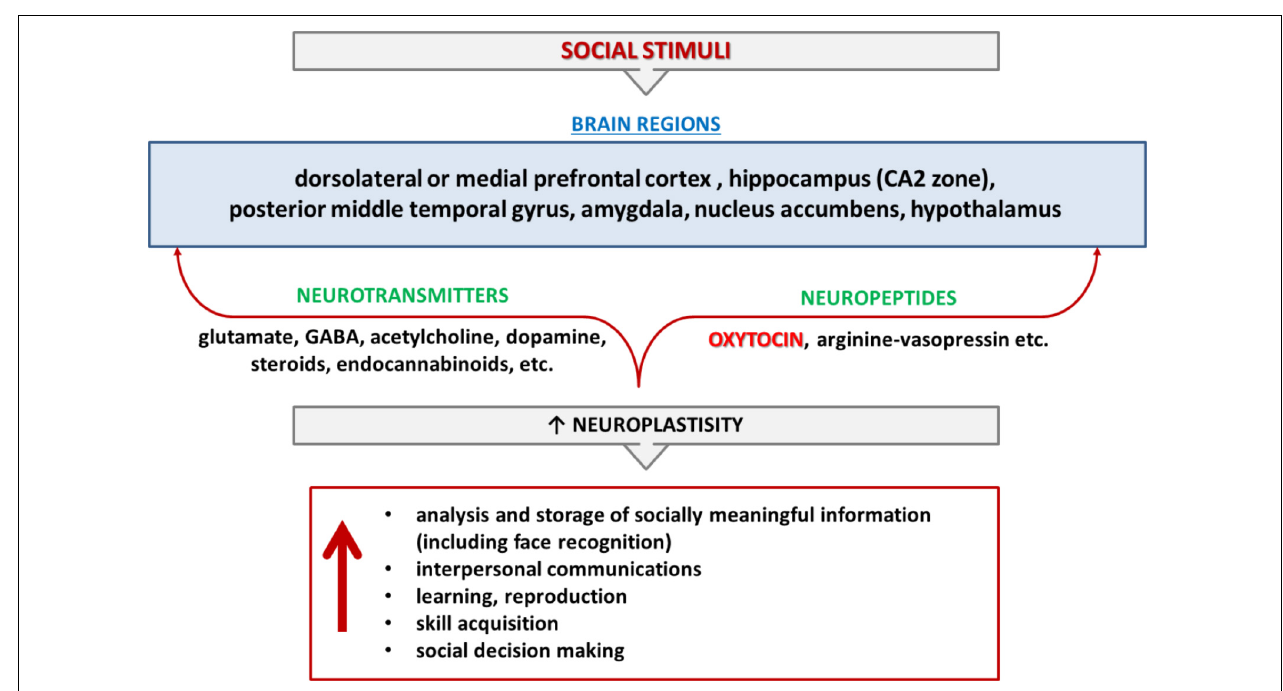
FIGURE 1 | Cognition and memory of social interactions. Cognition and memory of social interactions are controlled by different brain regions and mediated by various neurotransmitters (glutamate, GABA, acetylcholine, dopamine, steroids, endocannabinoids, etc.) and neuropeptides (oxytocin, arginine-vasopressin) in mammalians. Red color indicates the items that are in the review’s